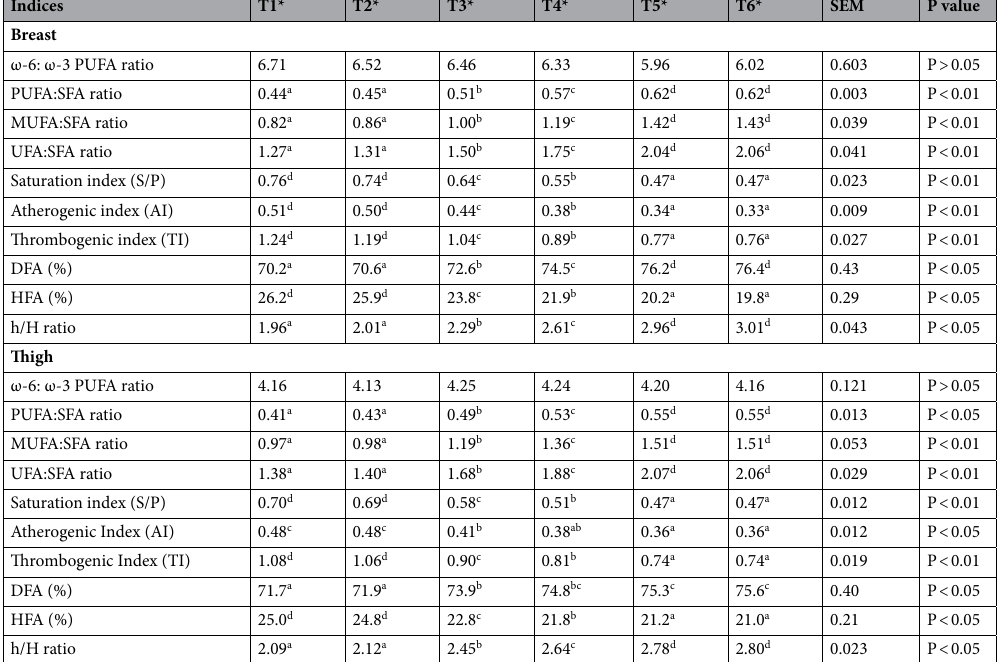
Table 4. Effect of dietary supplementation of Bifidobacterium bifidum (BFD) and Mannan-oligosaccharides (MOS) on health related indices of broiler chicken meat (n = 6 × 2). *T1(no BFD/MOS/BMD), T2 (20 mg